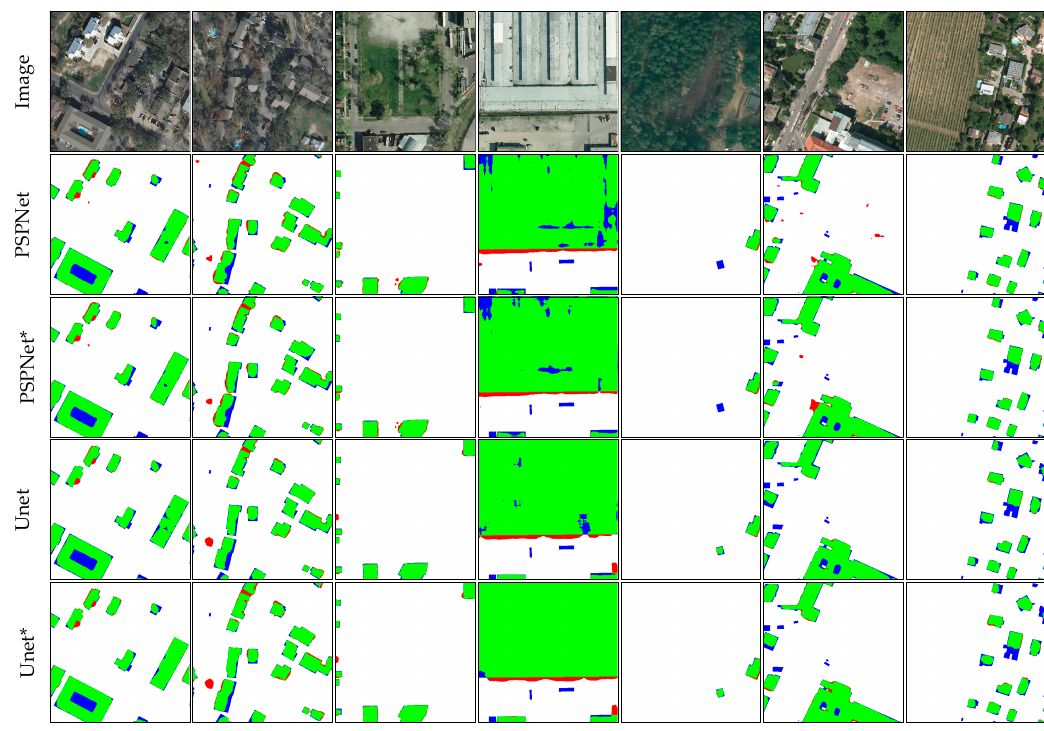
Figure 11. Results on the different areas of the INRIA dataset. From the 2nd to the 5th, the building maps are predicted from the naive PSPNet, refined PSPNet, UNet, and refined UNet.